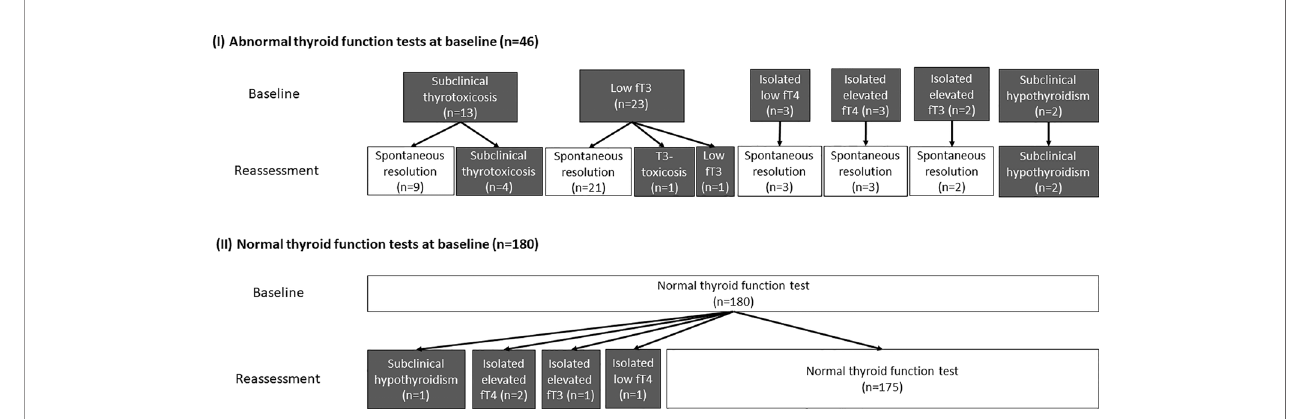
FIGURE 1 | The evolution of the thyroid function of all 226 patients (grey boxes represent abnormal thyroid function while white boxes represent normal thyroid function).